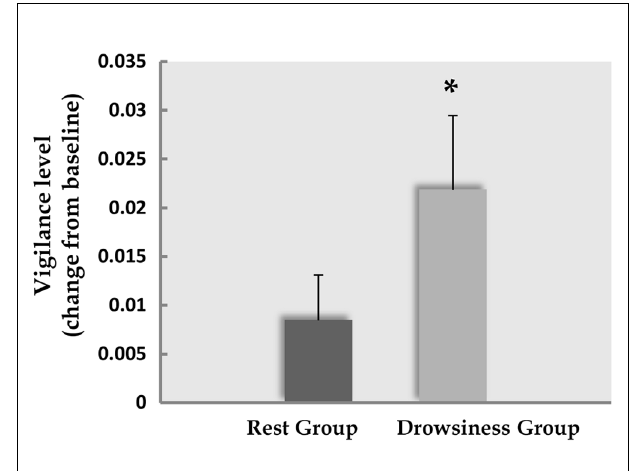
FIGURE 2 | Decline in EEG-based vigilance scores. Decline (mean and standard error) in EEG-based vigilance scores (higher score relates to increased drowsiness) between the baseline rest scan and the 15-minute rest scan. Dark column represents the “rest” group; light column represents the “drowsiness” group. A significant decline in vigilance level was found only in the “drowsiness” group. * p < 0.05.